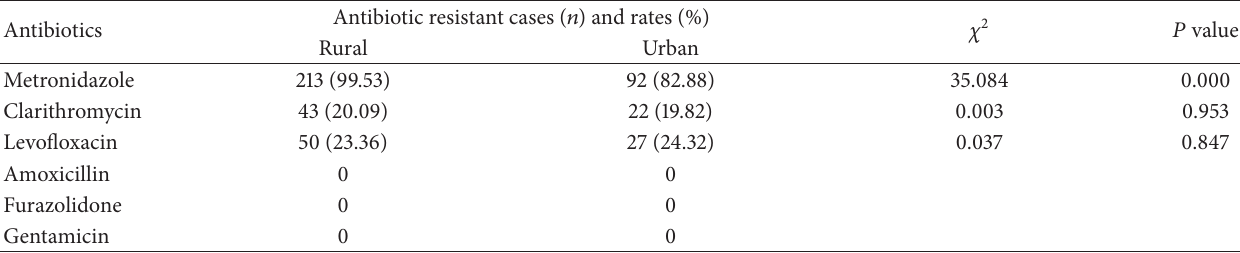
Table 2: Correlation between H. pylori antibiotic resistance and CYP2C19 genetic polymorphism in rural patients. CYP2C19